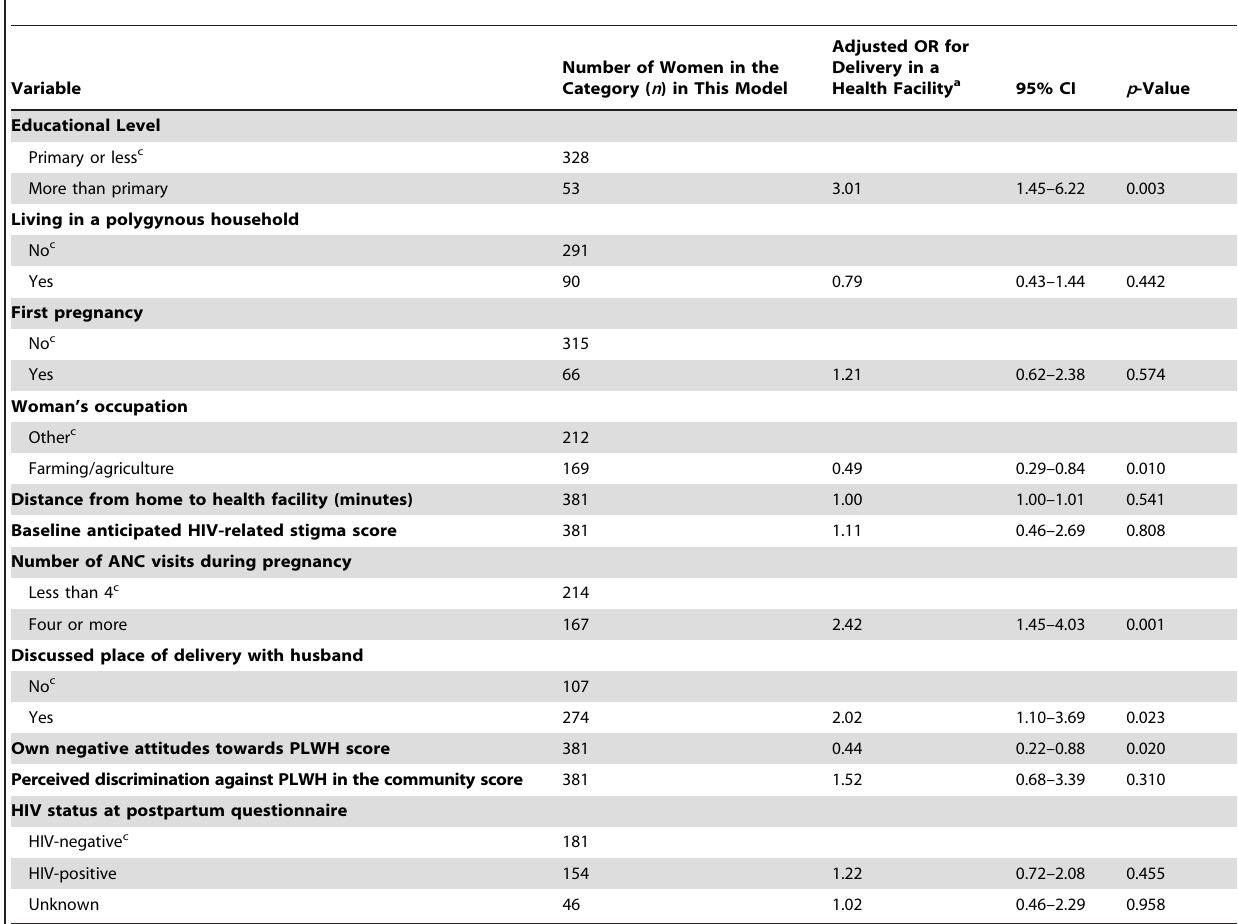
Table 4. Multivariate logistic regression of HIV-related stigma measures and other individual-level predictor variables on delivery in a health facility ( n =